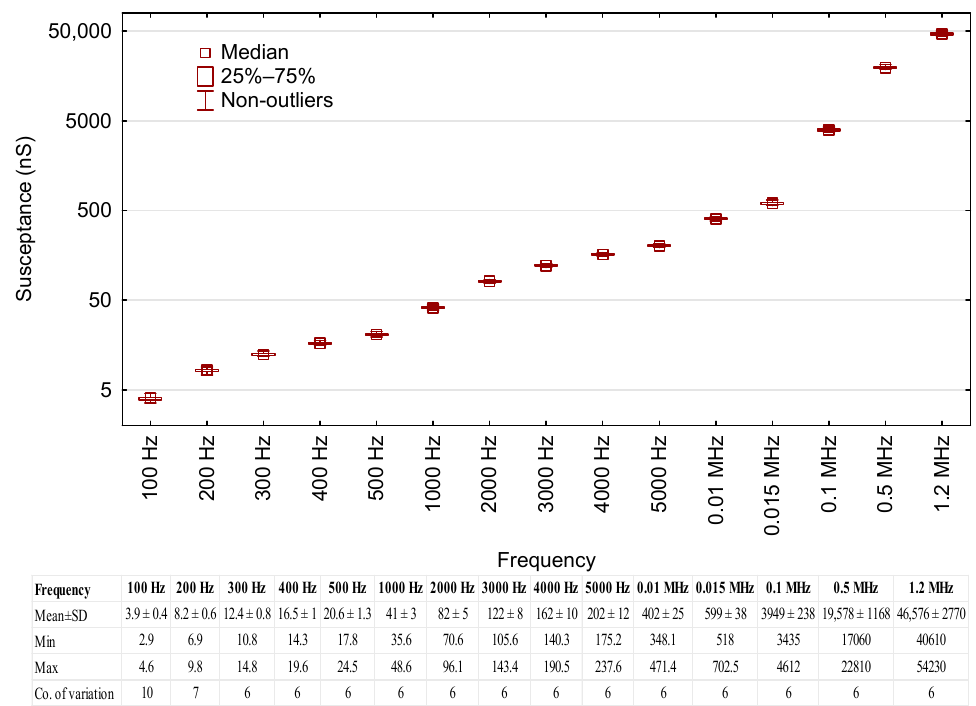
Figure 5. Susceptance readings for the tested oil samples, including base data for the results. An analysis of susceptance as a function of test voltage frequency shows that the two variables are positively correlated. Susceptance rose from 3.9 nS at 100 Hz to 46,577 nS at 1.2 MHz. Also of note is the high stability of the coefficient of variance, which was around 6% for most of the readings. The only higher values were recorded for 100 and 200 Hz (coefficient of variation = 10% and 7%, respectively). The assorted readings for the indi- vidual oils at different frequencies had low coefficients of variation, suggesting that sus- ceptance can be a useful parameter for the in-service diagnosis of engine oil quality. How- ever, comprehensive research on used oil is needed to fully confirm this finding.